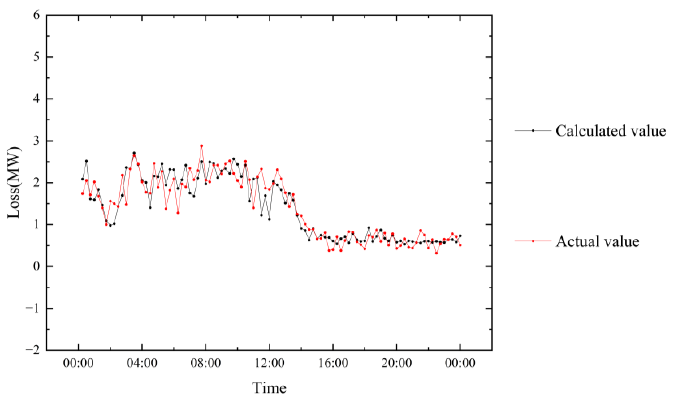
Figure 9. Calculation of cable loss results based on wind turbine power.